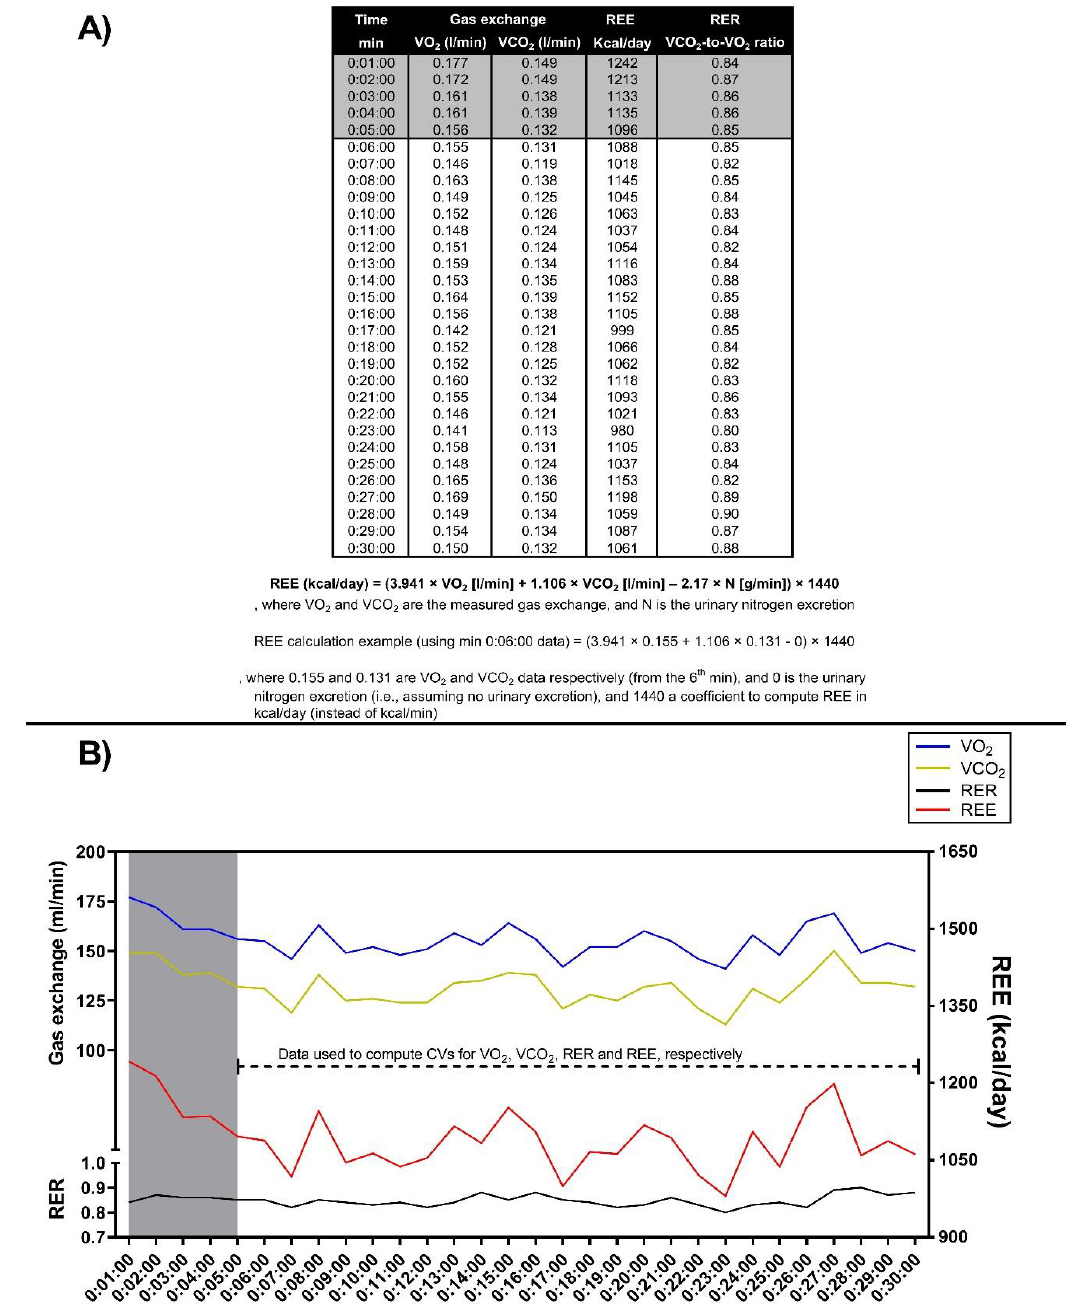
Figure 1. Representation of the procedure for computing the respiratory exchange ratio (RER) and the resting metabolic rate (RMR; i.e., resting energy expenditure [REE] estimated using the equation proposed by Weir [30] and assuming no urinary nitrogen excretion) using the measured volume of oxygen consumption (VO 2 ) and volume of carbon dioxide production (VCO 2 ) gas exchange (Panel ( A )), and the procedure for computing each coefficient of variation (CV, in percentage; Panel B). These are actual data from a participant included in the present study. The blue line represents the VO 2 , the yellow line represents the VCO 2 , the black line represents the RER, and the red line represents the RMR (i.e., REE). In both panels, the data highlighted in gray represents the 5 min data discarded following current recommendations [15]. In Panel ( B ), the dashed line represents the data used to compute the CV for each gas exchange parameter (i.e., CV for VO 2 , VCO 2 , RER, and REE). In Panel B, the left y -axis represents the gas exchange in milliliters per minute (mL/min) and RER, and the right y -axis represents the REE in kilocalories per day